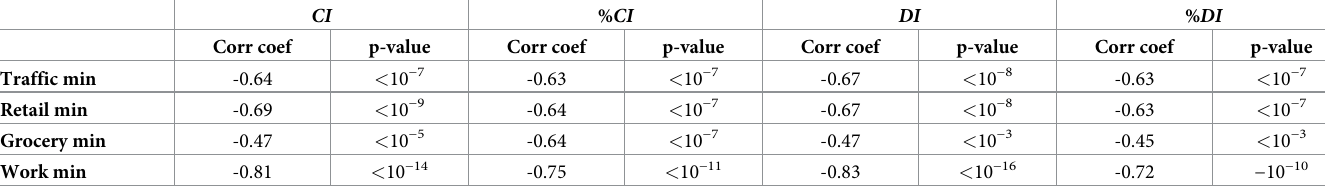
Table 1. Spearman rank correlations between our measures of epidemic size and our measures of social mobility in New York counties at the time of PAUSE. The epidemic measures (computed on the day PAUSE started) are: cumulative incidence for each county ( CI , columns 1 and 2); percent cumulative incidence (% CI , columns 3 and 4); daily incidence ( DI , columns 5 and 6); percent daily incidence (% DI , columns 7 and 8). The first row shows the correlations of these epidemic measures with the lowest traffic level (which occurred briefly after the start of PAUSE), as a fraction of the original traffic baseline. The other three rows show the corresponding correlations with the lowest mobility to Retail, Grocery and Workspace (as a fraction of the baseline). The corresponding significance values are shown as separate columns. The corre- lations with daily incidence DI and % DI were based on values from the window smoothed time series; the corresponding correlations based on raw time series were very